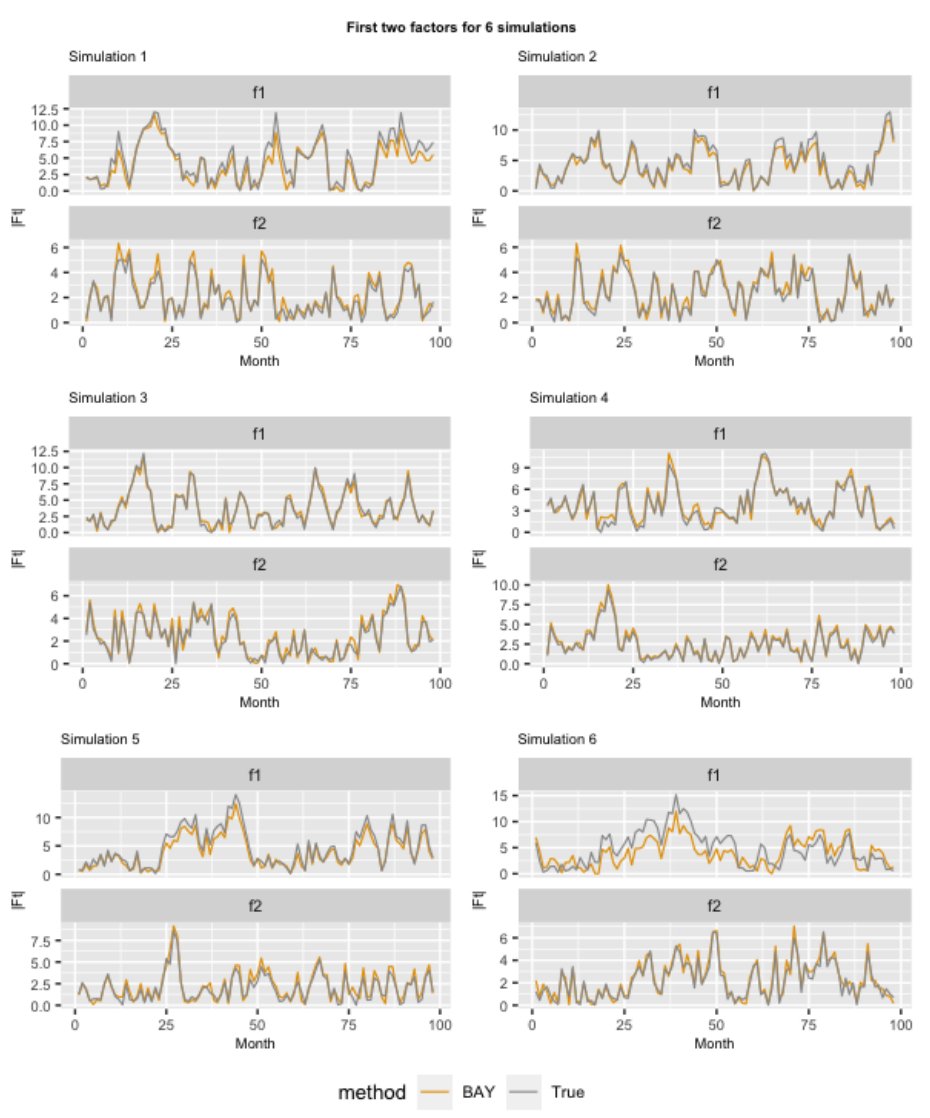
Figure 5. In-sample fit of the latent factors for 6 simulations. Absolute value is used for both true factors and in-sample fits. Yellow lines represent in-sample fitted value and gray lines represent true value. In each subplot, the upper panel represents the comparison for the first factor, and the lower panel shows the comparison for the second